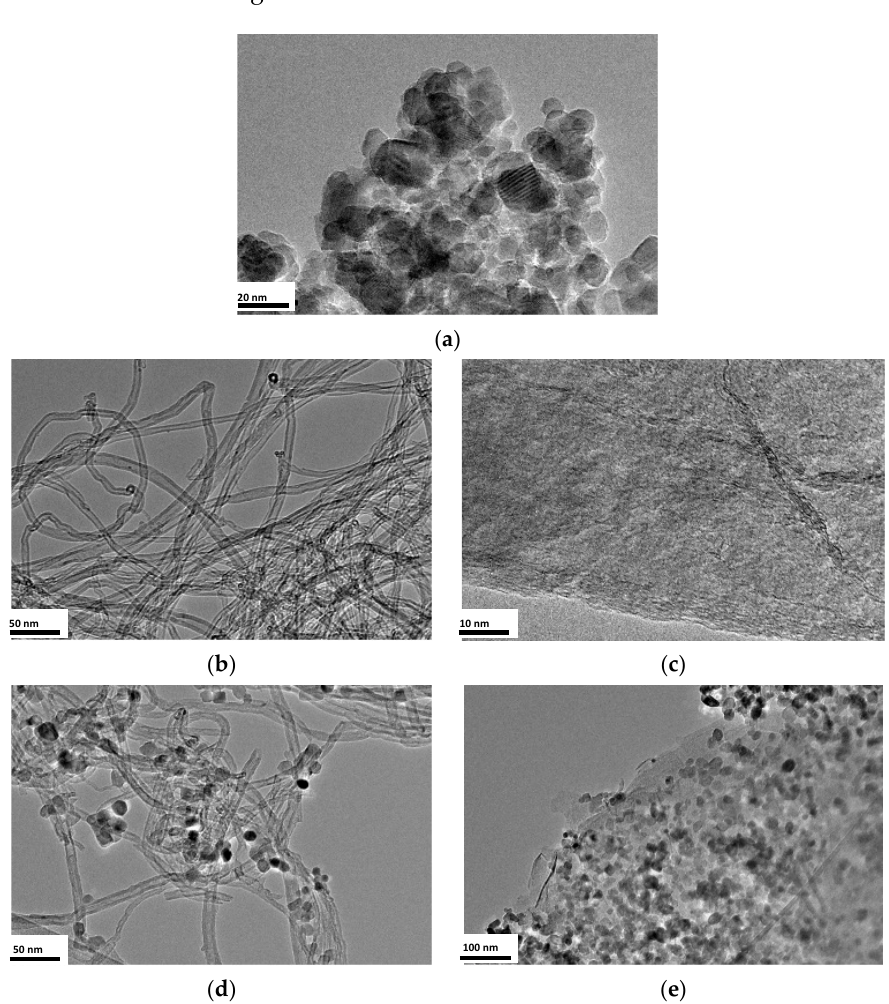
Figure 3. TEM images of different synthesized materials: ( a ) N 1 /TiO 2 , ( b ) N 2 /CNT, ( c ) N 10 /rGO, ( d ) N 1 /TiO 2 /CNT, ( e ) N 1 /TiO 2 /rGO.